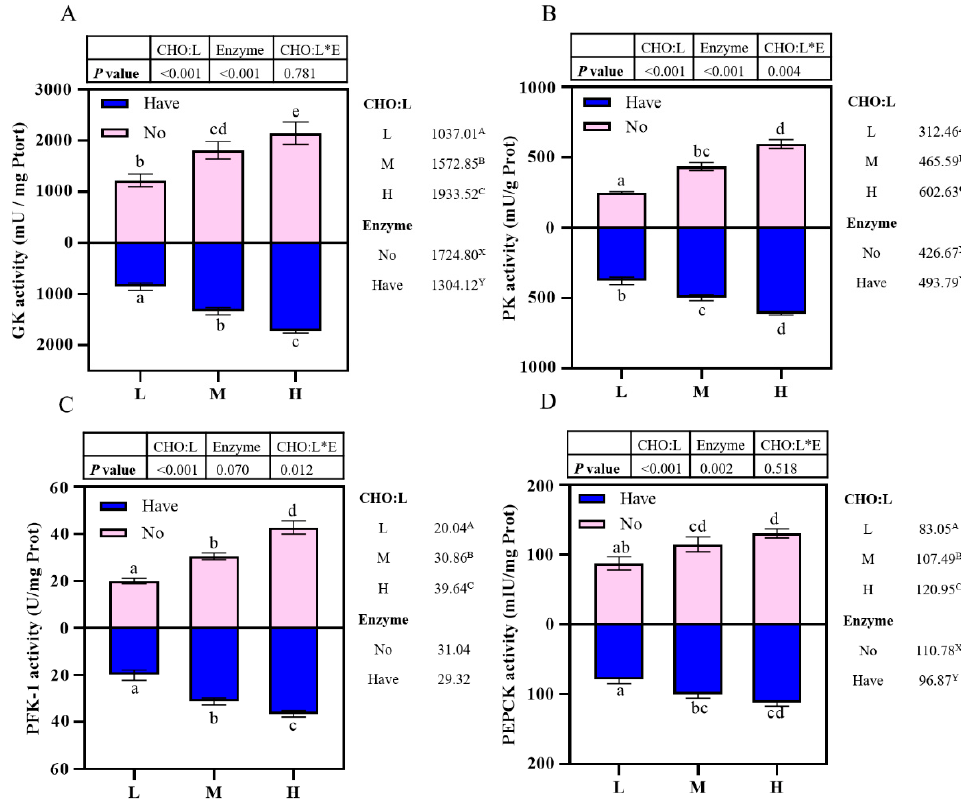
Figure 2. Effects of carbohydrase supplementation on hepatic enzyme activities in hybrid grouper fed different CHO:L ratios diets (Figure 2A = GK activity; Figure 2B = PK activity; Figure 2C = PFK-1 activity; Figure 2D = PEPCK activity). Data represent means of three fish in each group; error bar indicates S. D. Average of different superscripts in the same column (a, b, c, d, e, etc. Or A, B, C, etc. Or X, Y) are significantly different ( p < 0.05) . (Dietary CHO:L ratio = A, B, C, etc.; Dietary carbohydrase = X, Y); no means no enzyme, have means enzyme.